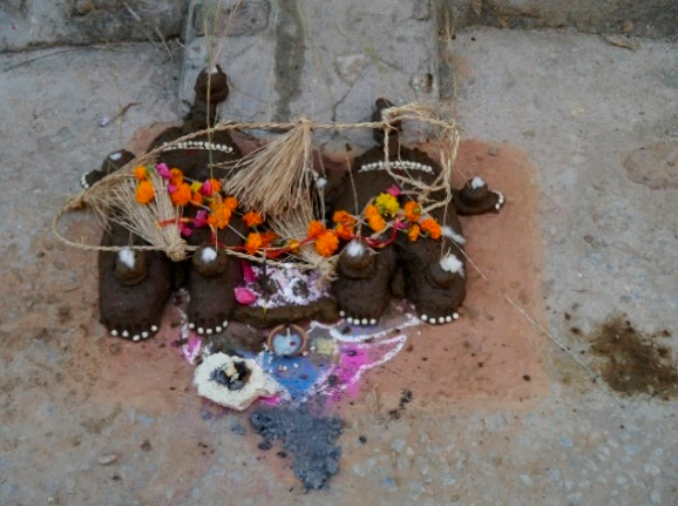
Figure 7. Govardhan beautified with corn, cotton, hay, flowers and an old door string, Havala 2017 (picture by author).